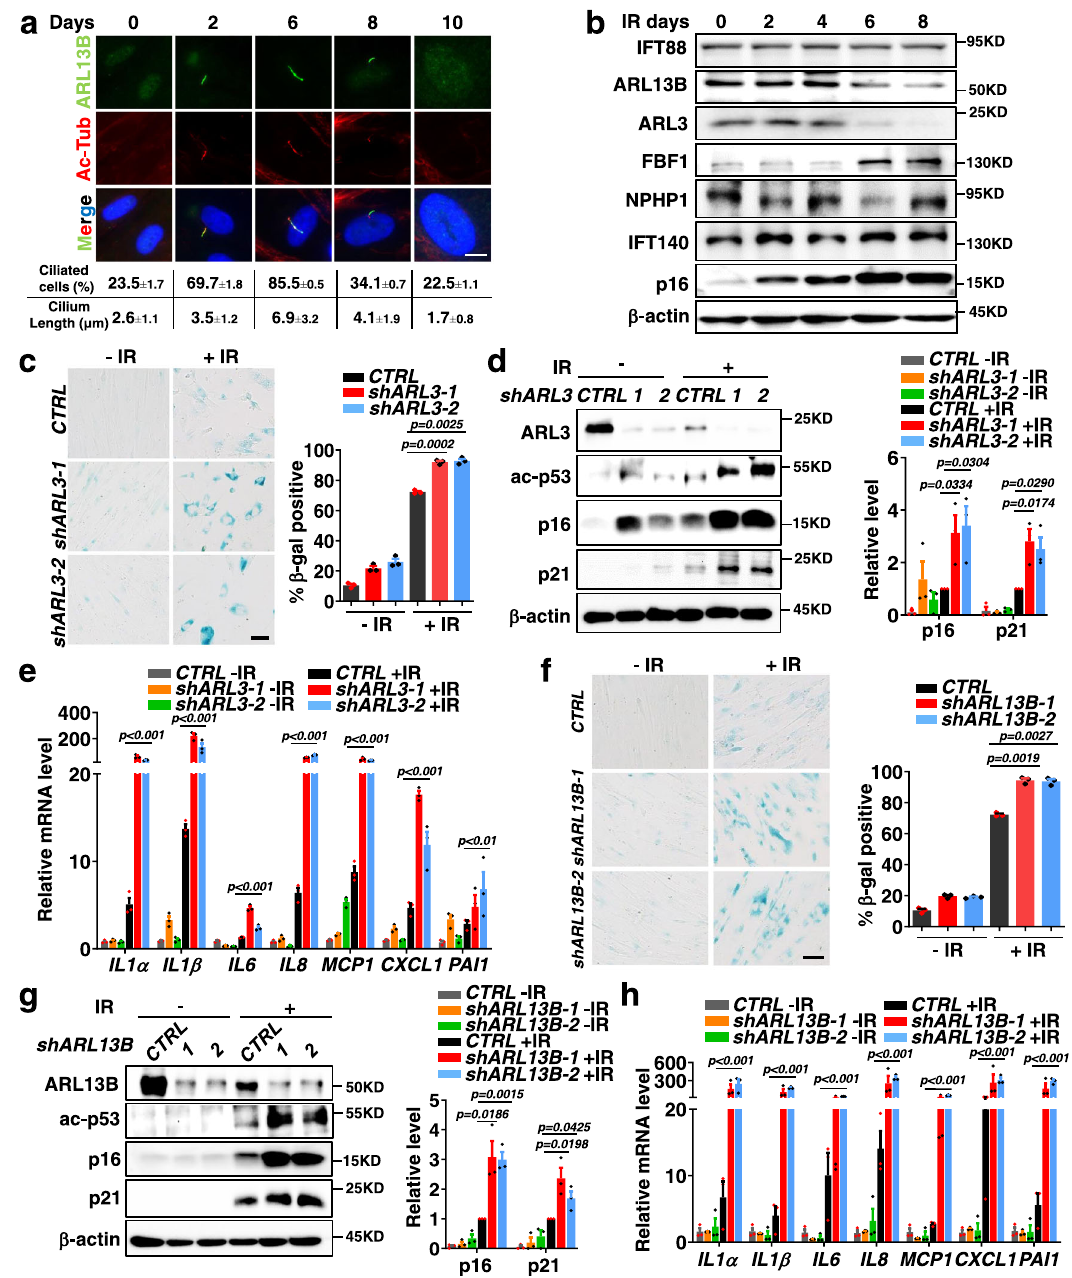
Fig. 1| De fi ciency ofJoubert syndromeGTPaseARL3 orARL13B promotesDNA damage-induced senescence. a Immuno fl uorescent images for changes of pri- mary cilia in IMR-90 cells after senescence-induction by irradiation. Cilia were labeledwithacetylatedtubulin.Scalebar,10 μ m.Threeexperimentswererepeated independently with similar results. b Western blot showing changes in ciliary pro- tein levels after senescence-induction in IMR-90 cells by irradiation. Three experiments were repeated independently with similar results. c – e SA- β -gal stain- ing (n>100 cells per experiment) ( c ), western blot of senescence markers ( d ) and relative mRNA levels of SASP genes ( e ) in IMR-90 cells stably expressing control